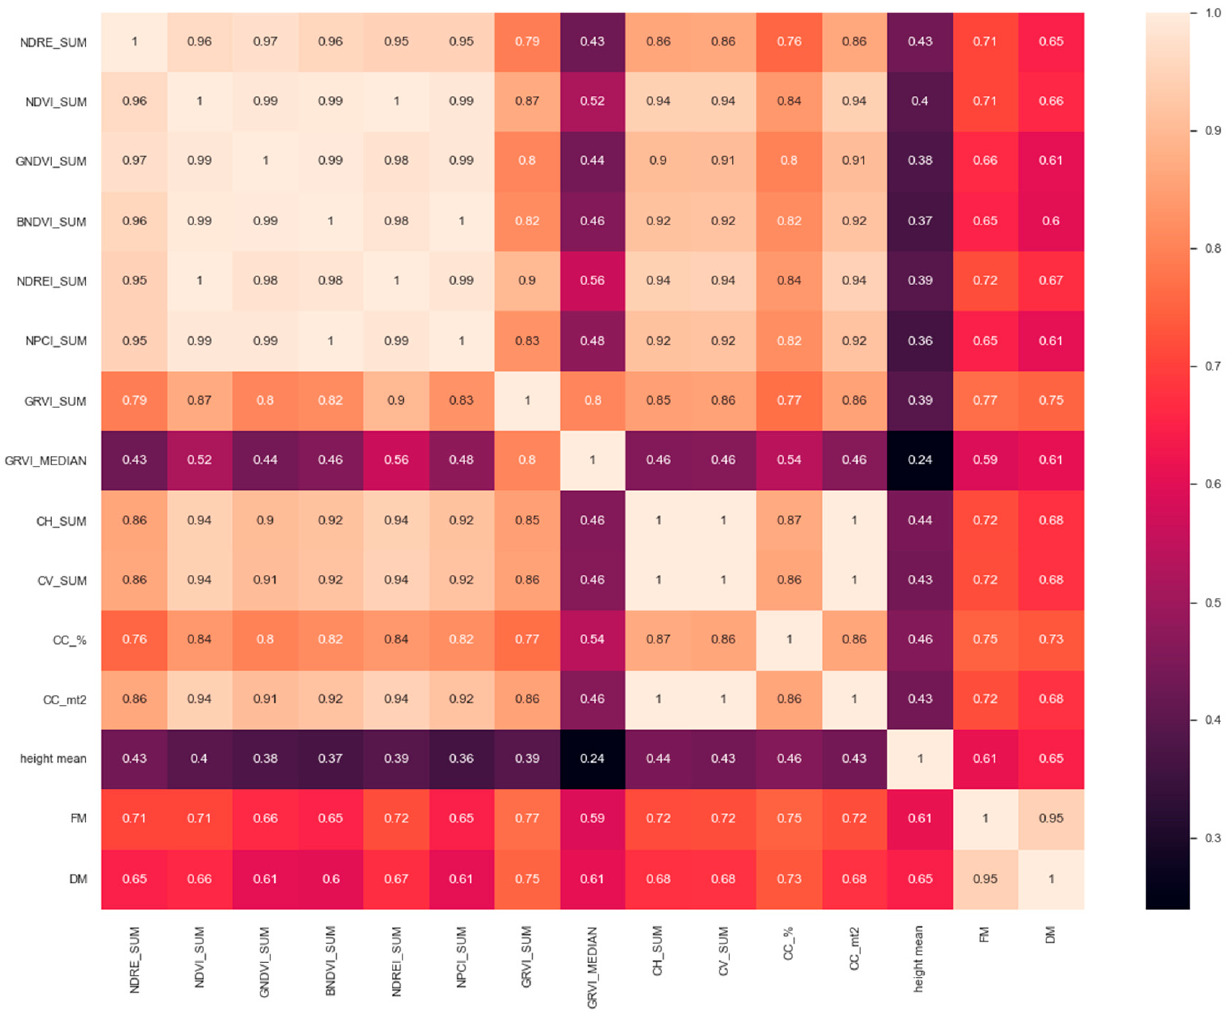
Figure 6. Correlation graph between GTD and UAV remote sensing variables. The lighter color intensity shows a higher correlation near one, and the darker color intensity shows near − 0.4 (negative correlation).